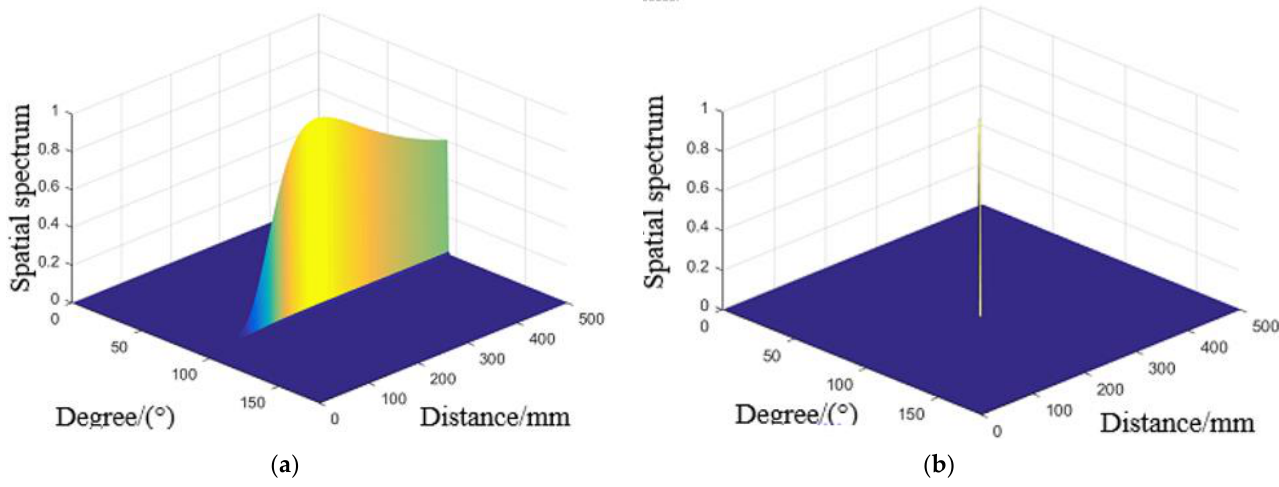
Figure 13. Spatial spectrum estimated for 600Hz by ( a ) Stander 2D-MUSIC ( b ) Compensated 2D-MUSIC.